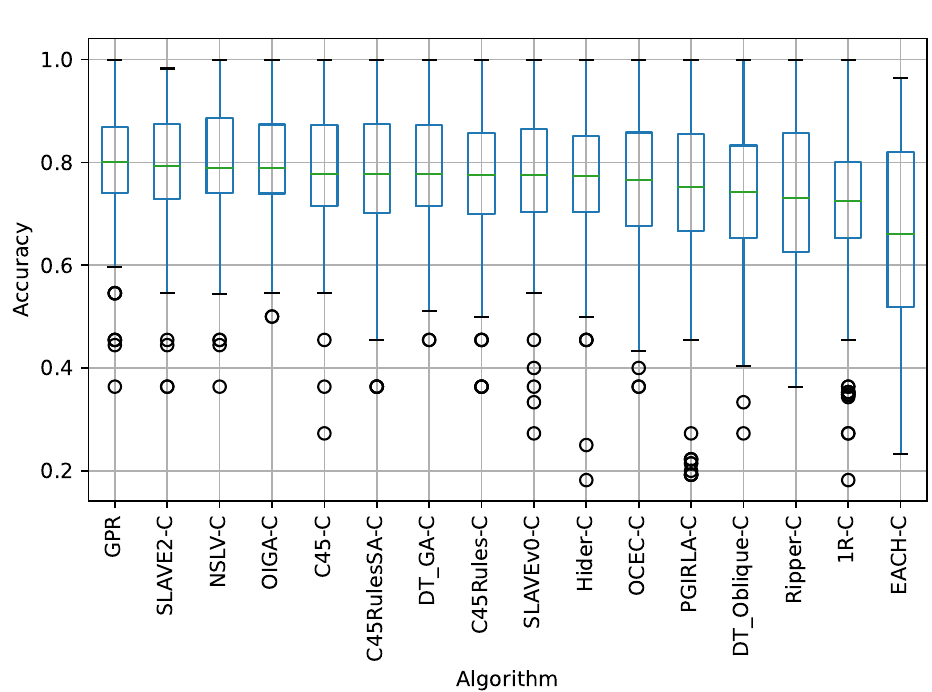
Figure 3. Distribution of ACC values for each algorithm in all